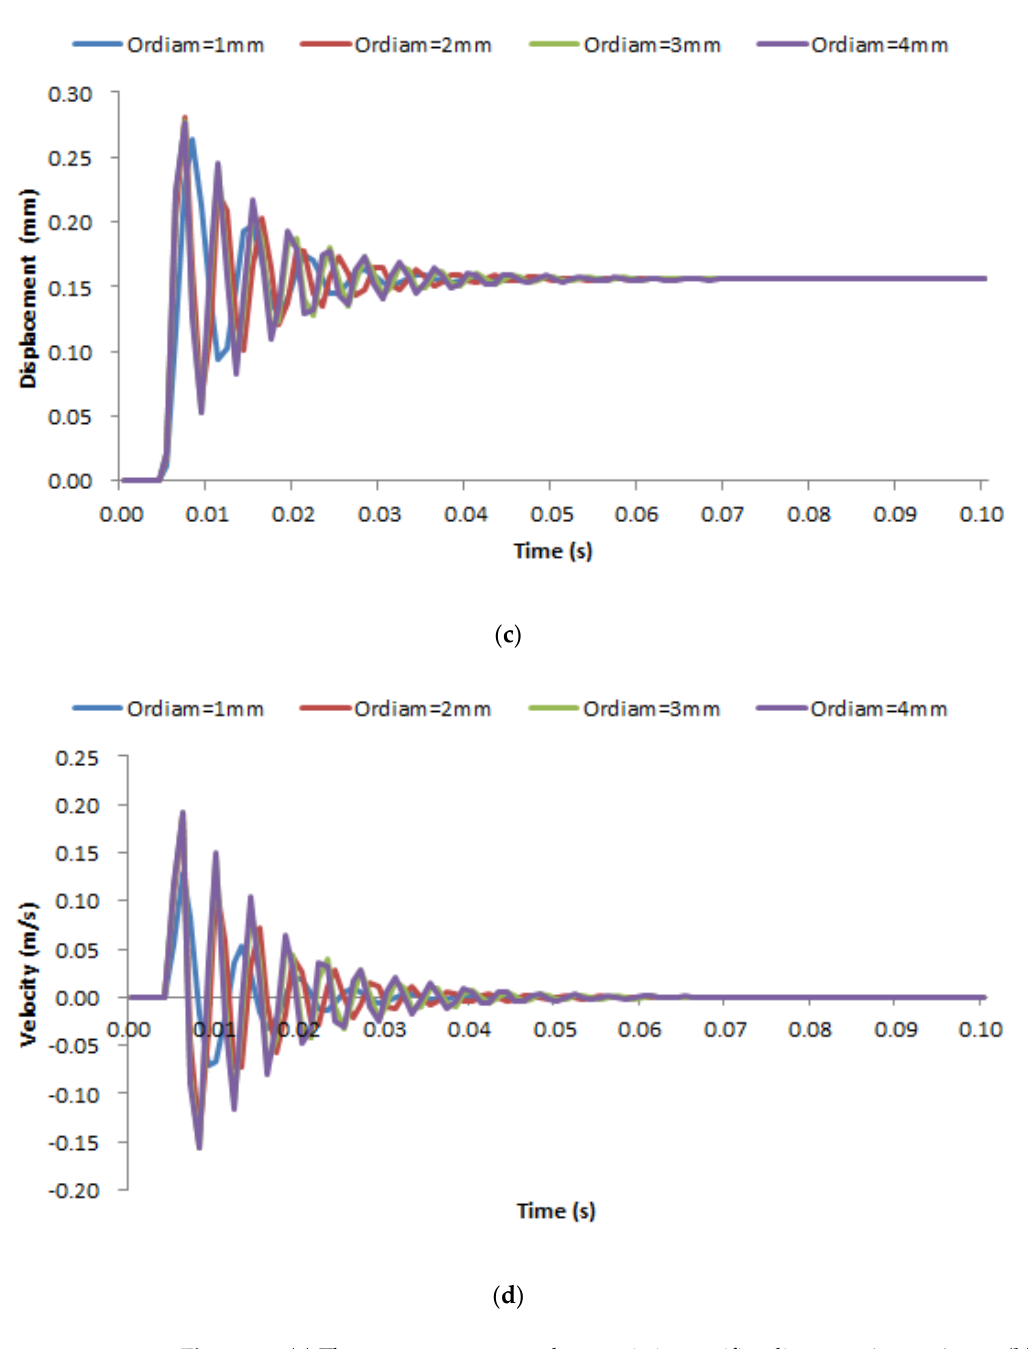
Figure 10. ( a ) The pressure response characteristics — orifice diameter: 1 mm~4 mm. ( b ) The flowrate response characteristics — orifice diameter: 1 mm~4 mm. ( c ) The displacement response characteristics of the valve element — orifice diameter: 1 mm~4 mm. ( d ) The velocity response characteristics of the valve element — orifice diameter: 1 mm~4 mm.